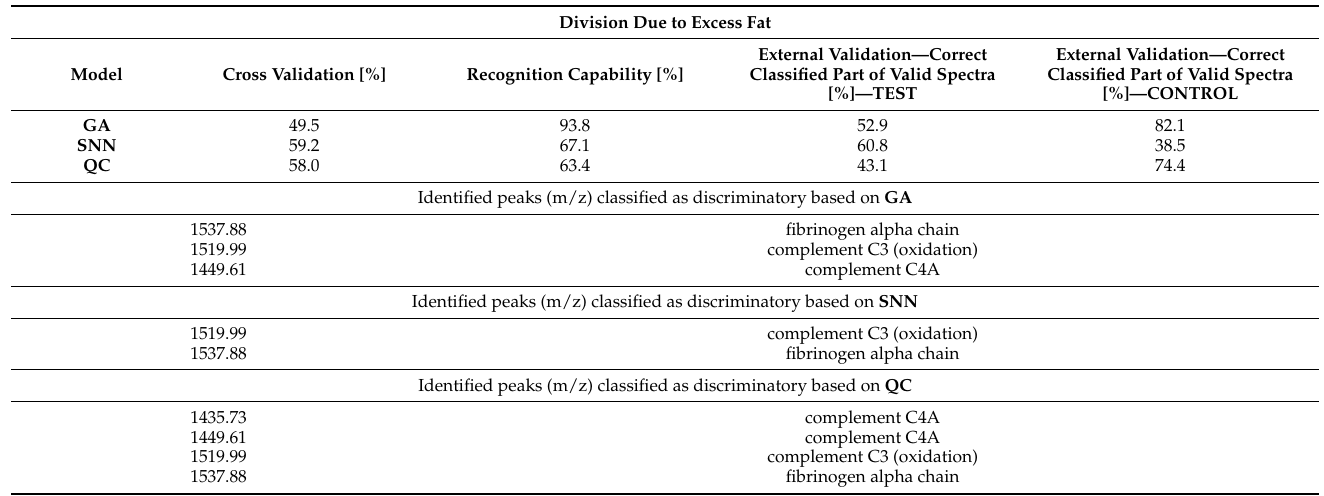
Table 4. Division due to excess body